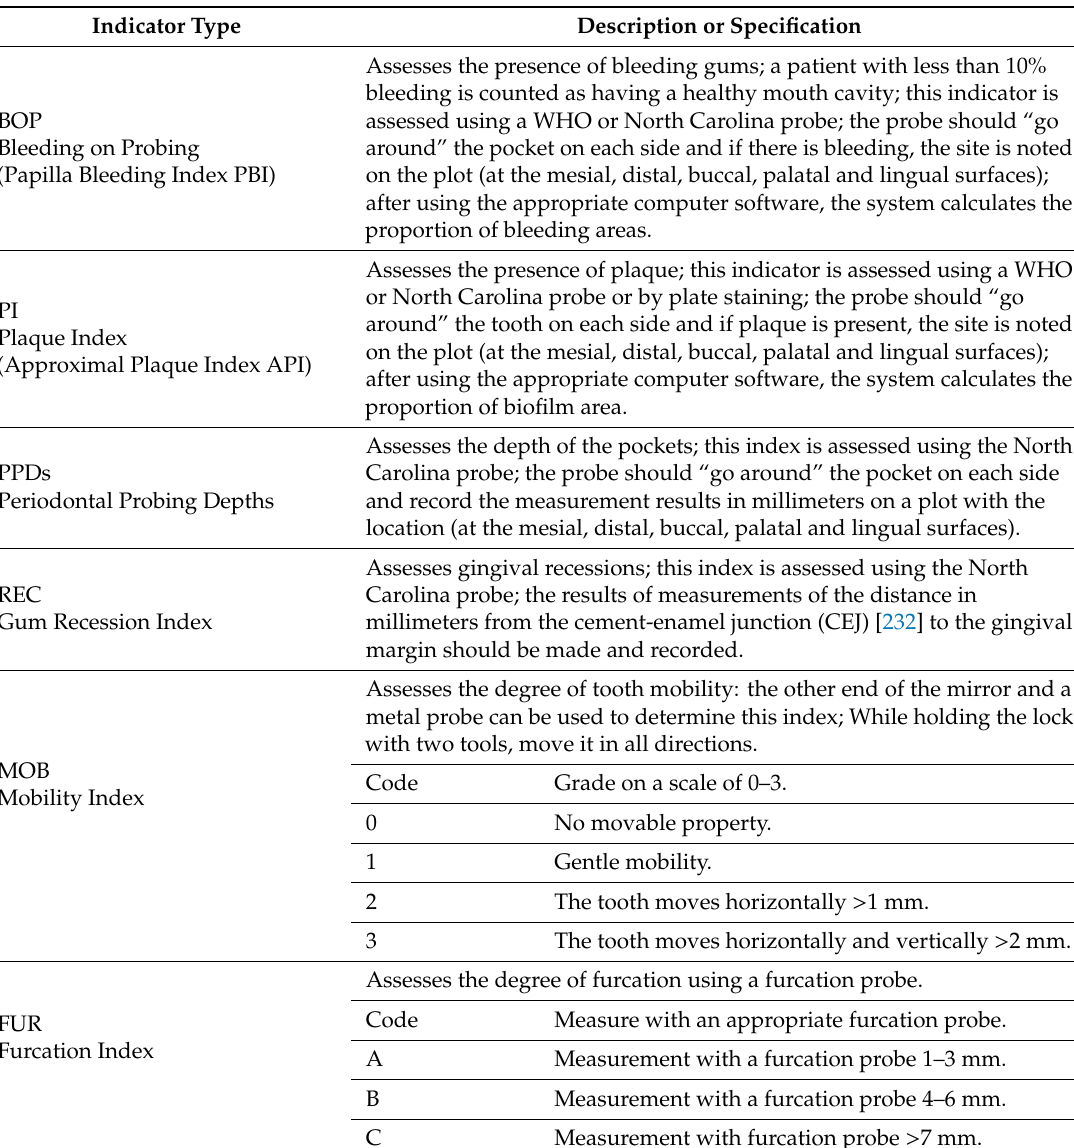
Table 6. Indicators determined in order to objectively assess the condition of the periodontium and its